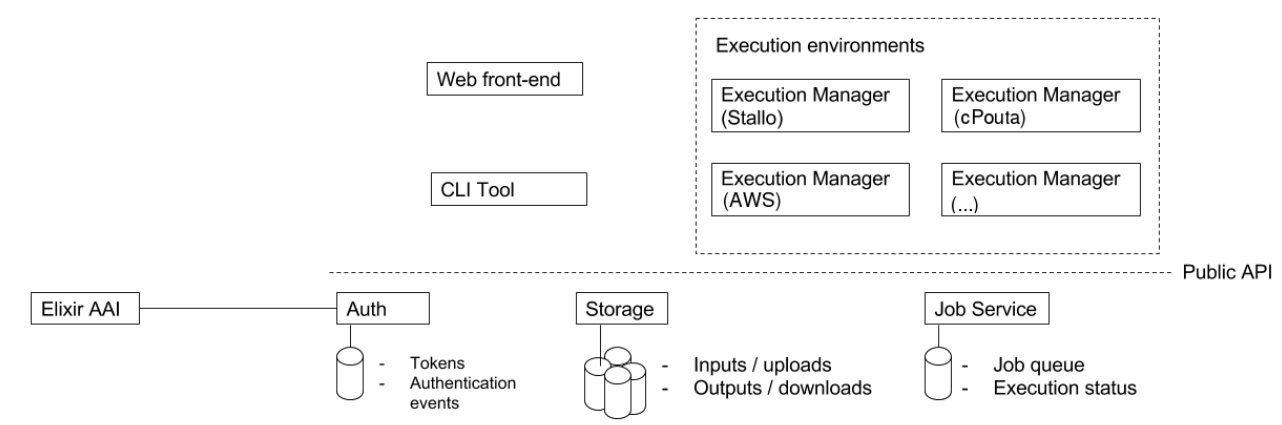
Figure 1. META-pipe backend architecture has three servers located at the University of Tromsø. The authorization server, which is integrated with the ELIXIR AAI, enables login for Elixir users. The storage server stores all META-pipe input, output and provenance data. The job server schedules and maintains submitted analysis jobs. The jobs are implemented as Spark programs that are executed by an execution manager running in an execution environment. There can be multiple execution managers distributed over many HPC clusters and